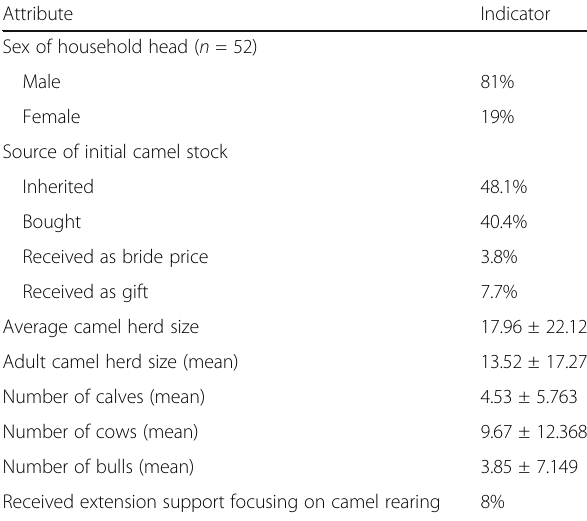
Table 2 Camel acquisition and herd composition